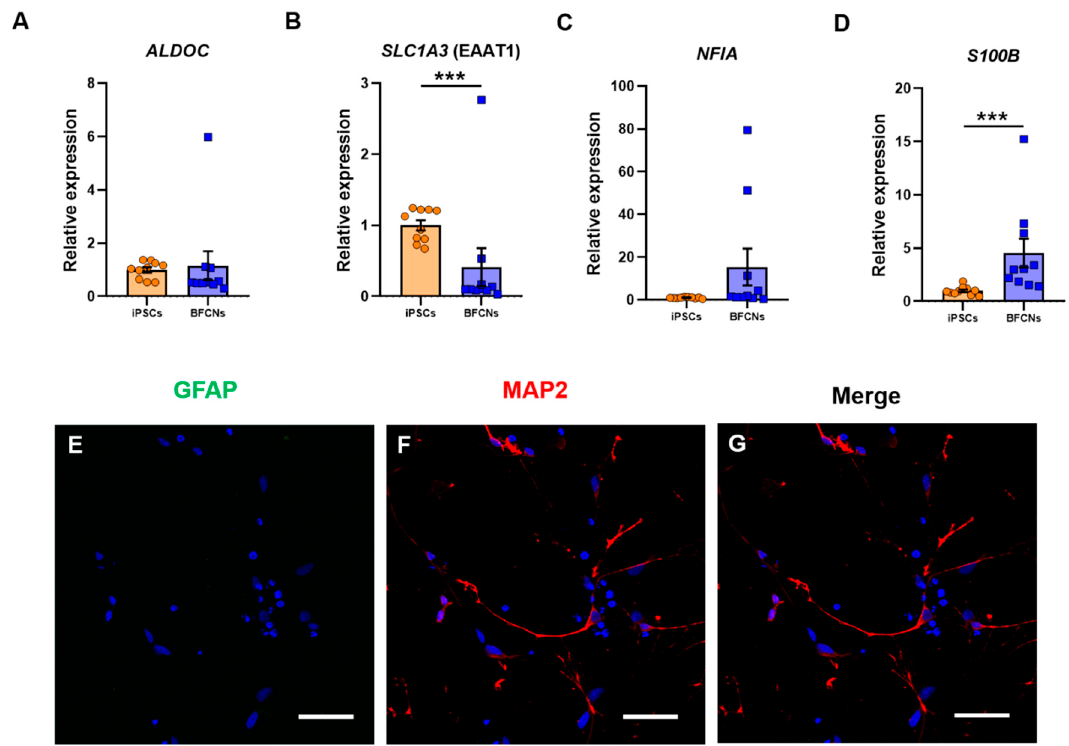
Figure 5. Expression of astrocytic markers. The iPSC and BFCN samples were analysed by nCounter (Nanostring) and, after normalisation of total amount of RNA molecules to the housekeeper genes, results are shown as fold change of BFCN cultures over iPSCs. Analysis of the astrocyte markers ( A ) ALDOC , ( B ) SLC1A3 (EAAT1), ( C ) NFIA and ( D ) S100B . Data are derived from 10 iPSC lines and 10 BFCN differentiated samples from 1 independent differentiation for each line. Individual data are shown. Histogram bars represent mean values and error bars represent S.E.M. Graphs show *** p ≤ 0.001, by Kolmogorov-Smirnov test. BFCN cultures were matured for 4 weeks and immunocytochemistry for general neuronal markers and specific cholinergic neuronal markers was performed. ( E–G ) Representative confocal pictures of the BFCN cultures at week 4 of BFCN maturation with the nuclear marker Hoechst 33,342 in blue. ( E ) Astrocyte marker GFAP in green. ( F ) Dendritic marker MAP2 in red. ( G ) Merged picture of G and H. Scale bars = 50 μ m.